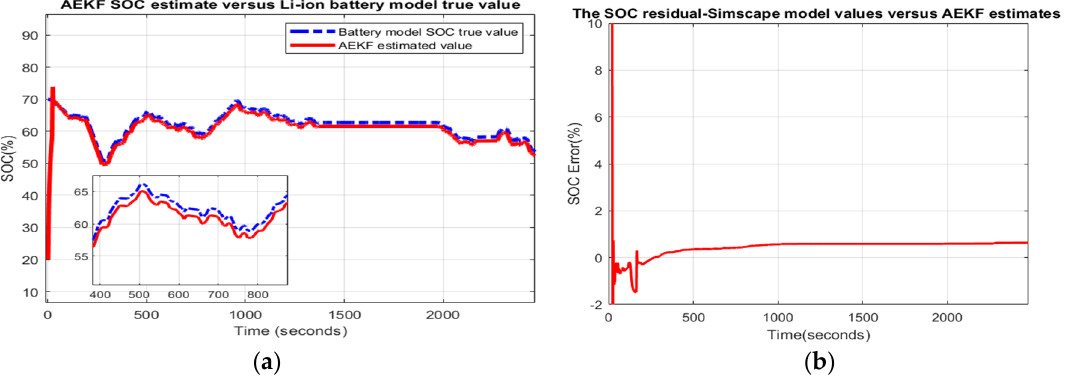
Figure 5. Robustness to simultaneous changes, SOCini = 0.2, and output temperature profile changes;